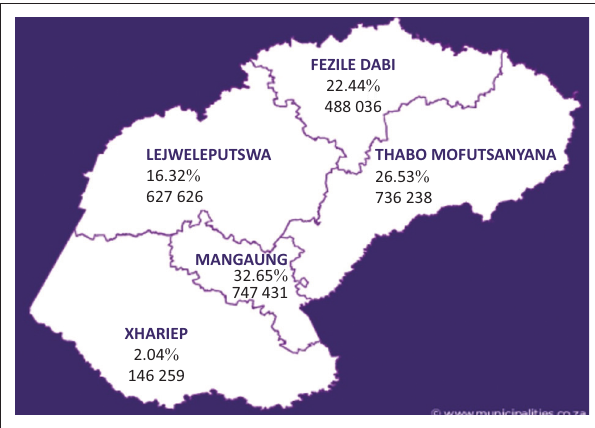
FIGURE 2: Referrals from outside of Universitas Hospital ( % ) by municipal district 20 and population in 2011.